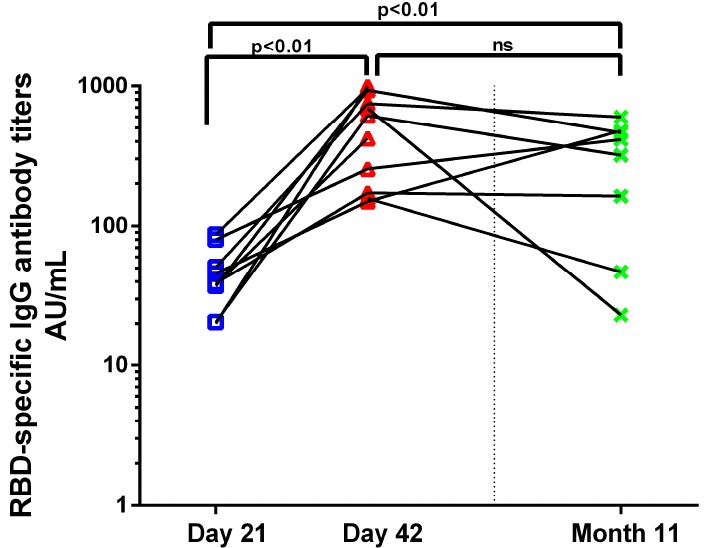
Figure 4. Humoral response to BNT162b2. Kinetics of RBD-specific IgG antibody titers before (D21) and 3 weeks (D42) after the second BNT162b2 dose and 3 weeks after an anamnestic dose (Month 11) in vaccinated individuals. Each dot represents a serum sample.